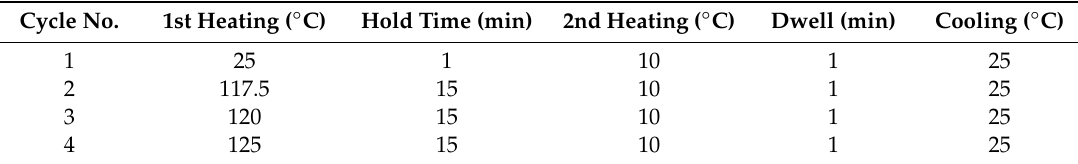
Table 4. DSC experiment